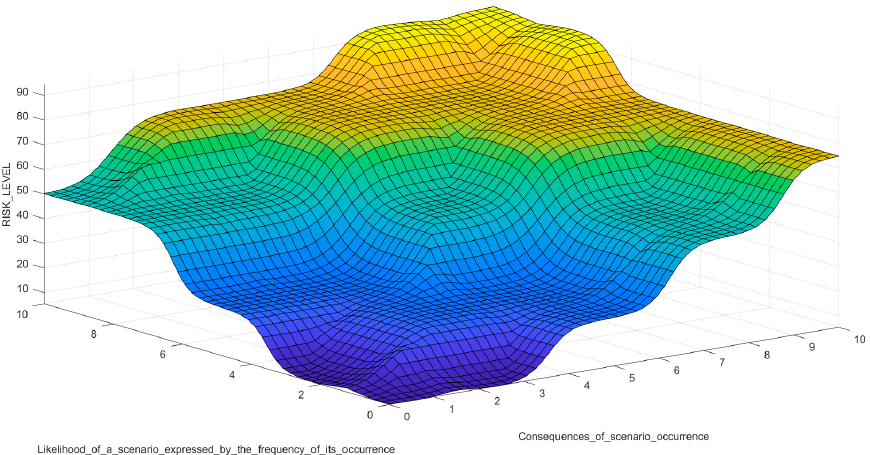
Figure 8. Surface risk level index for the proposed risk assessment model in MATLAB. All rules are with weight = 1.